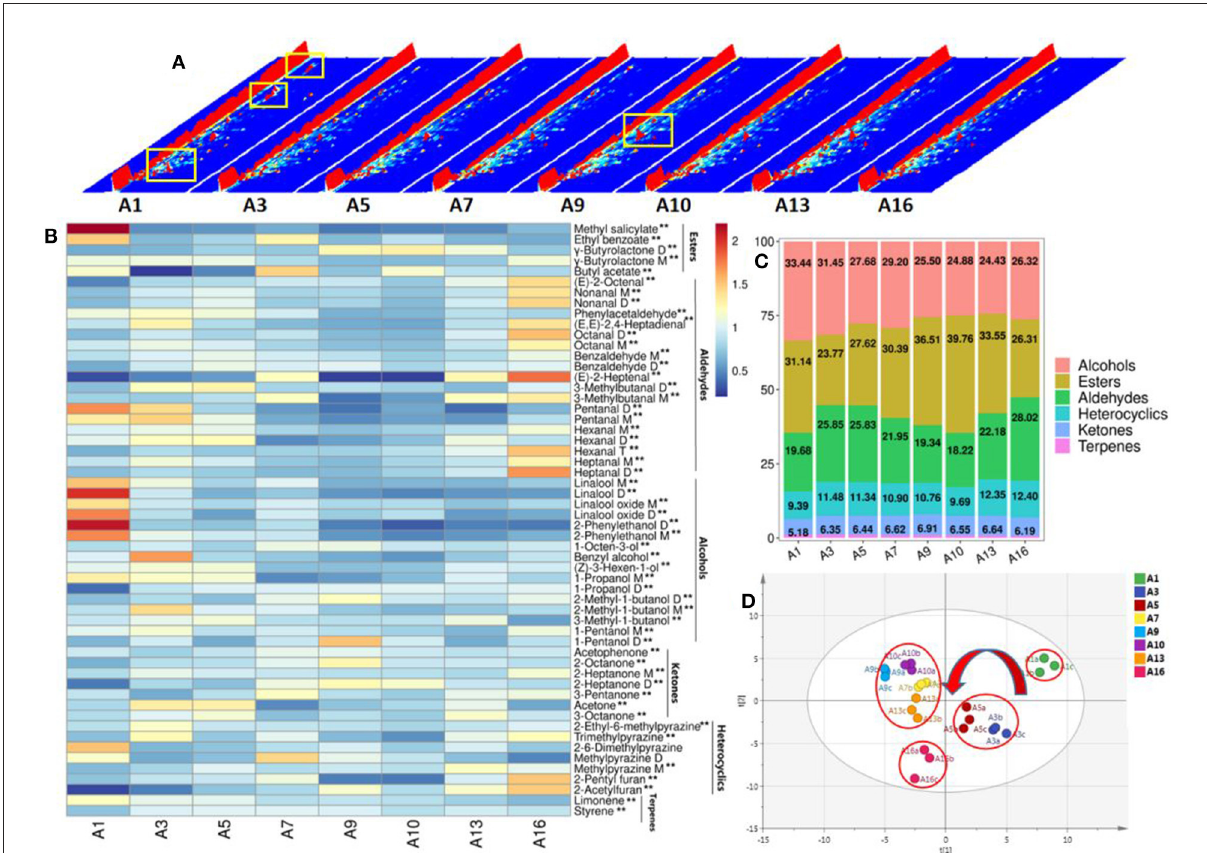
FIGURE3 VOCs change during storage of CWT. (A) Total atlas of VOCs. (B) Heat map of VOCs change. Low levels in blue and high levels in red. **( P < 0.01). (C) The column diagram of the proportion of VOCs species. (D) Principal component analysis of VOCs. R 2 X = 0.98, Q 2 =